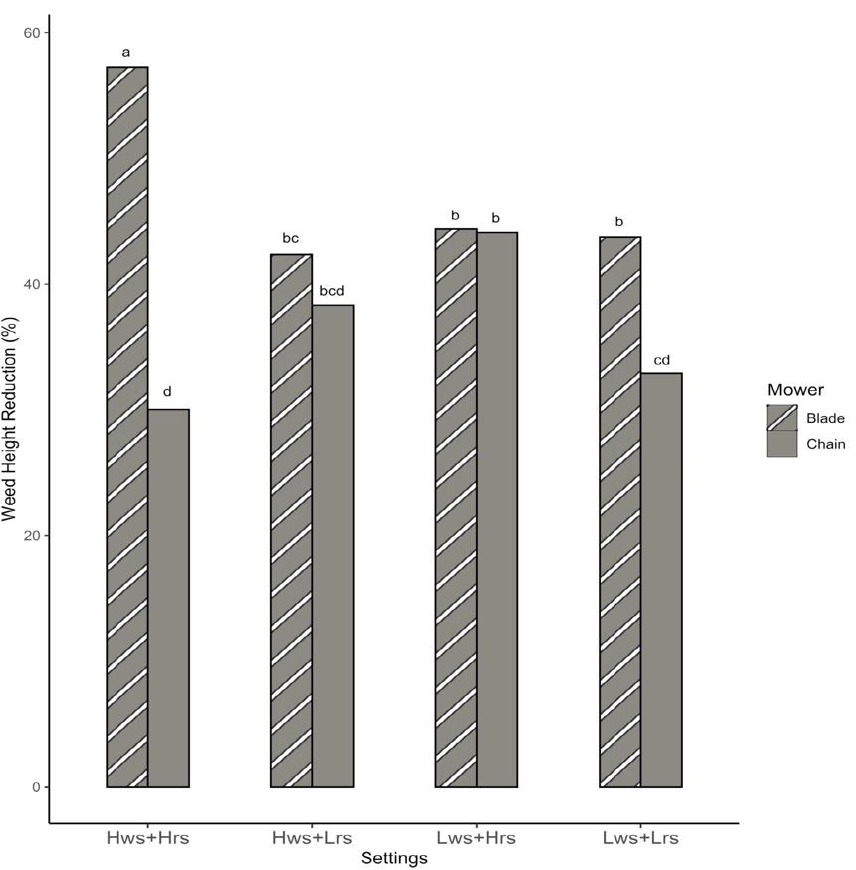
Figure 9. Effect of the interaction between mower version and setting configuration on weed height reduction. Means denoted by different letters are significantly different at p < 0.05 (LSD test). Hws — High working speed; Lws — low working speed; Hrs — high rotation speed; Lrs — low rotation speed.